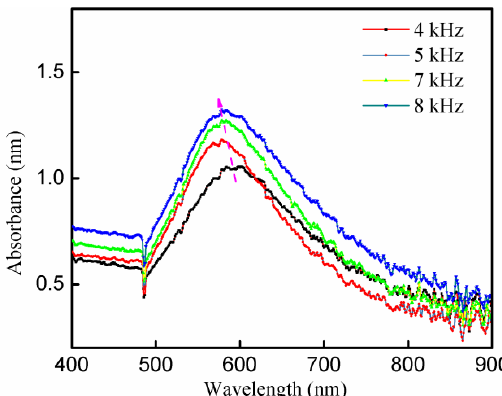
Figure 9. UV–Vis absorption spectra of AuNP under different pulse frequencies (applied voltage: 8.4 kV, treatment time: 7 min, HAuCl 4 / sodium citrate ratio of 1:3).